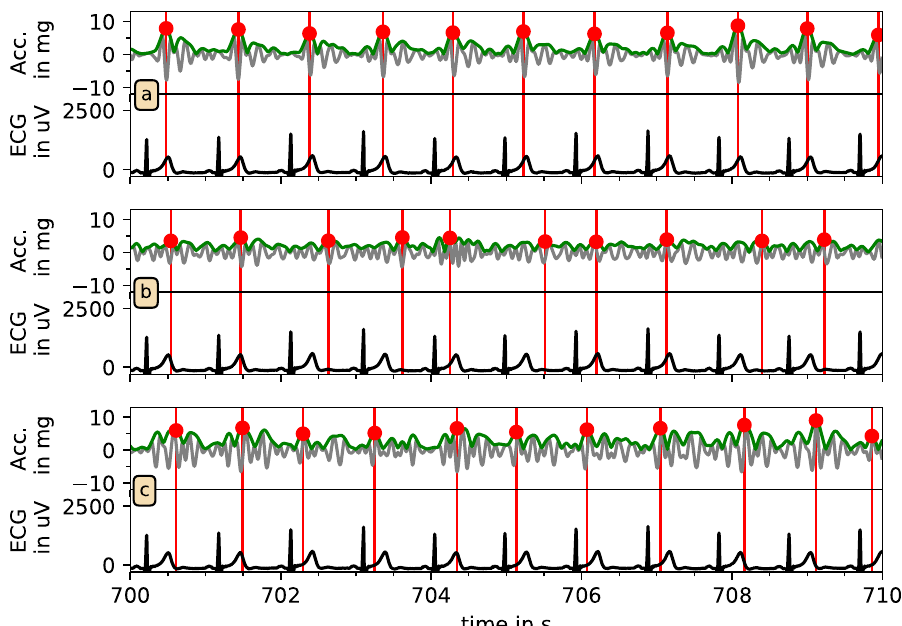
Fig 5. Selection of best axis for pulse wave reconstruction. The bandpass-filtered acceleration signals (gray), the corresponding Hilbert amplitudes (green) and the automatically identified candidate pulse wave peaks (red) are compared with the ECG (black) for all three axes of acceleration for another typical ten-second section of the recordings. Clearly, the detection reliability differs between the axes; in this case the best choice for beat detection is the x axis shown in panel